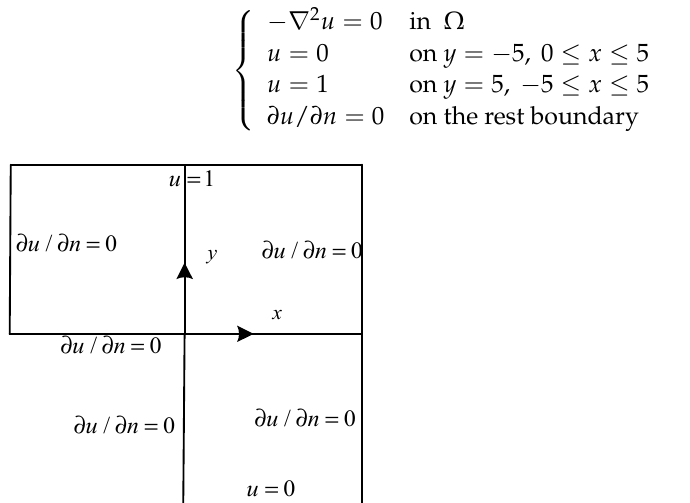
Figure 19. L-shaped domain and initial mesh.